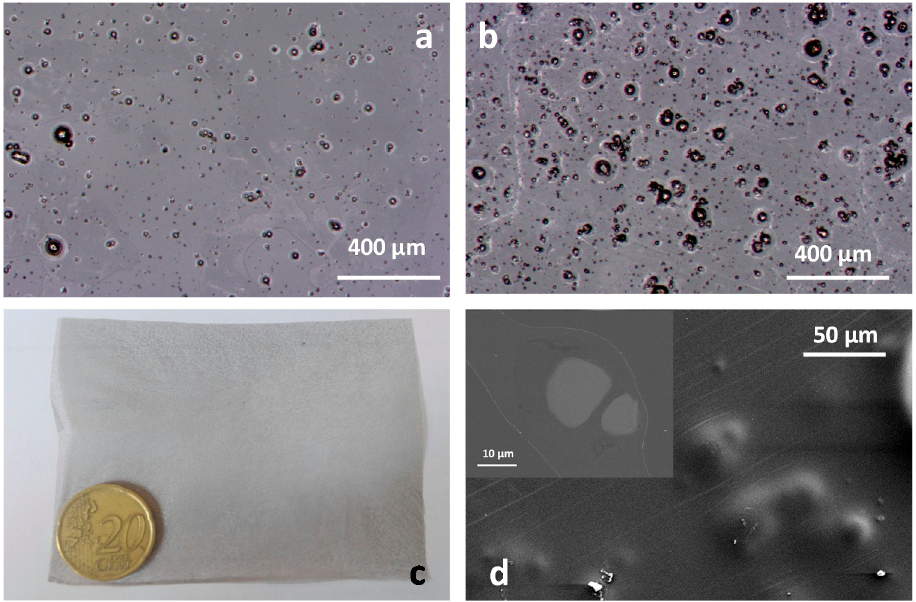
Figure 6. General view of the surface of F-5Mg ( a ) and F-10Mg ( b ) films, a macroscopic view of the film ( c ), and a detail of the surface of the imbibed Mg particles fully covered by the PLA ( d ). In order to evaluate what differences emerge in the drug release profile due to the change of composite shape from granules to films, the drug delivery test was carried out for F-5Mg and F-10Mg. Figure 7 shows the evolution of Mg 2+ lixiviation from the films and the SrR release determined by UV–Vis spectrometry during degradation in PBS. The Mg 2+ liberation has been previously described in the literature for similar films, but in static conditions and in absence of the drug [19]. When Mg particles are dispersed and immobilized in the biodegradable polymer, an increase of the release of Mg 2+ ions in relative terms during a first week (168 h) due to the film degradation is registered. The release decays after 28 days (336 h) since Mg particles practically dissolve in one month. In those terms, as expected, the higher is the Mg particles concentration in the film the faster is the Mg 2+ release.